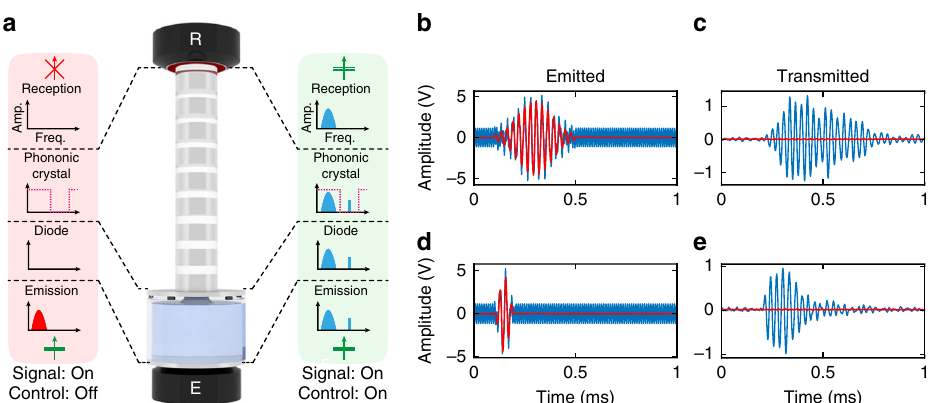
Fig. 4 Experimental demonstration of the underlying switch principle: a diagrams of the switch prototype; a phononic crystal (PC) has been added on top of the acoustic diode. The switch working principle is schematically described by the effect of activating a control wave on the transmitted signal wave. b , d emitted electrical waveforms (before a + 60 dB ampli fi cation by the power ampli fi er) for a harmonic control signal of frequency kHz and a signal wave in the form of a Gaussian pulse with a carrier frequency f 0 = 35 kHz and a spectral full width at half maximum of 5 kHz ( b ) and 20 kHz ( d ). c , e output signals transmitted by the switch device. The continuous red lines represent waveforms where the control signal is not turned on, while the continuous blue lines represent signals with the control signal